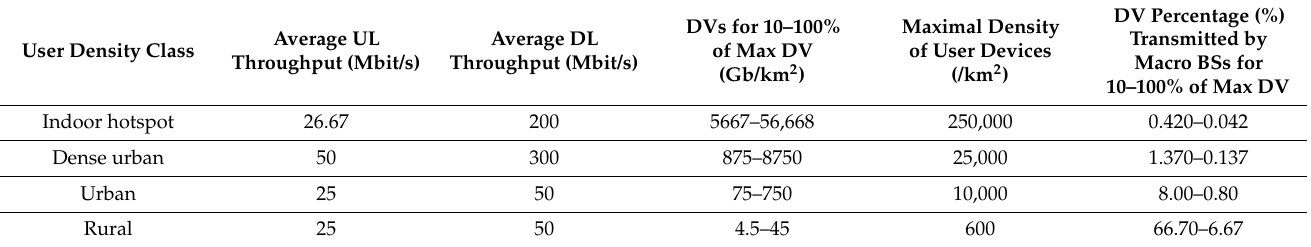
Table 1. Parameter values for the various device density classes and analyzed BS